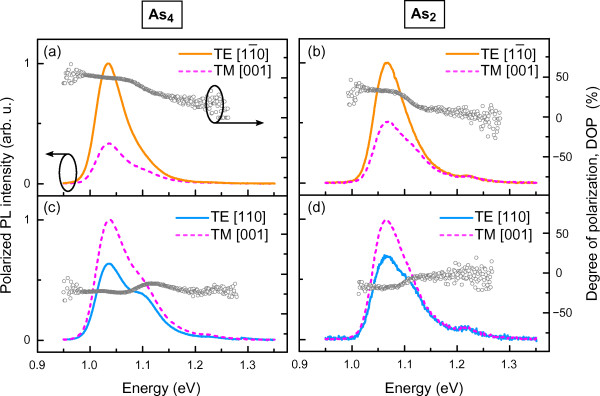
Room temperature linearly polarized photoluminescence spectra split into TE and TM modes for QR35 samples. The samples were grown using As4(a, c) and As2(b, d) sources. PL spectra are normalized to the most intense peak of the GS transitions in the InGaAs QRs. Circles indicate the optical anisotropy, represented by the degree of polarization, DOP.